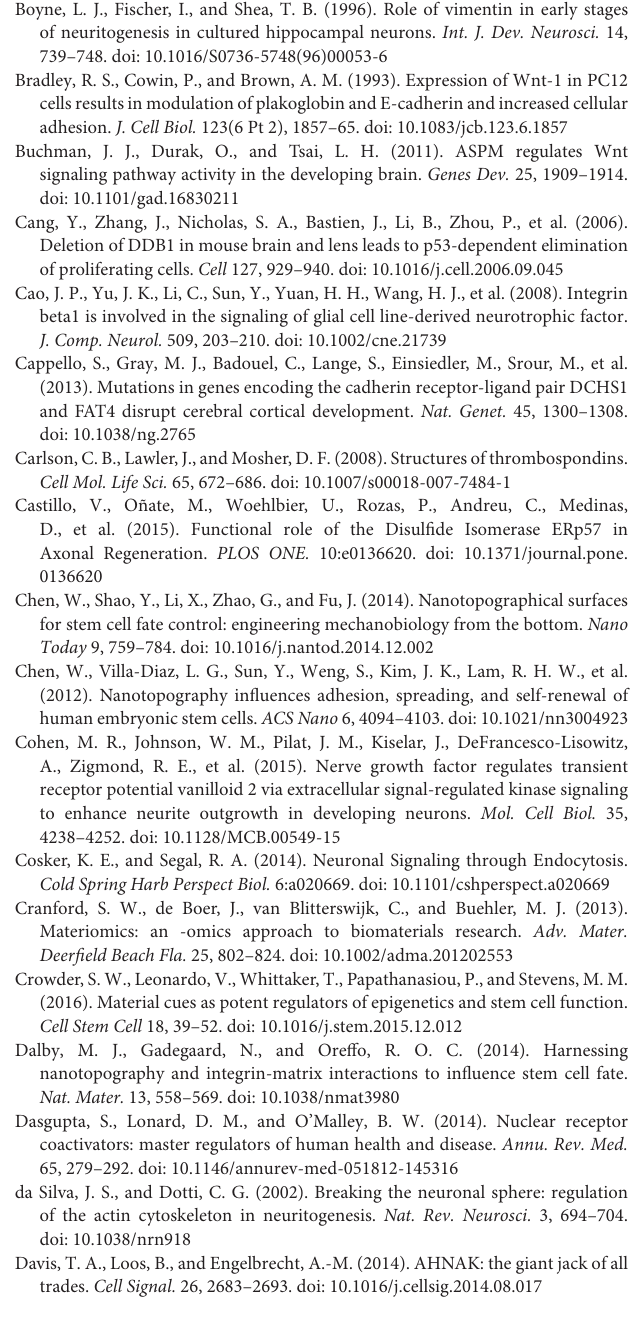
Table S23 | Proteins differently expressed comparing ns-Zr15 hypo vs ns-Zr15. List of the proteins annotated with Perseus software. Categorical annotation was supplied in form of Gene Ontology (GO) biological process (BP), molecular function (MF), cellular component (CC), keywords as well as in participation in a KEGG pathway and molecular complexes (CORUM). X = proteins with an opposed alteration of the expression level comparing ns-Zr15 vs flat-Zr with ns-Zr15 hypo vs ns-Zr15; Y = proteins altered in the same way in ns-Zr15 vs flat-Zr and ns-Zr15 hypo vs ns-Zr15. Table S24 | Proteins expressed only in ns-Zr15 (with respect to the comparison ns-Zr15, ns-Zr15 hypo). List of the proteins annotated with Perseus software.